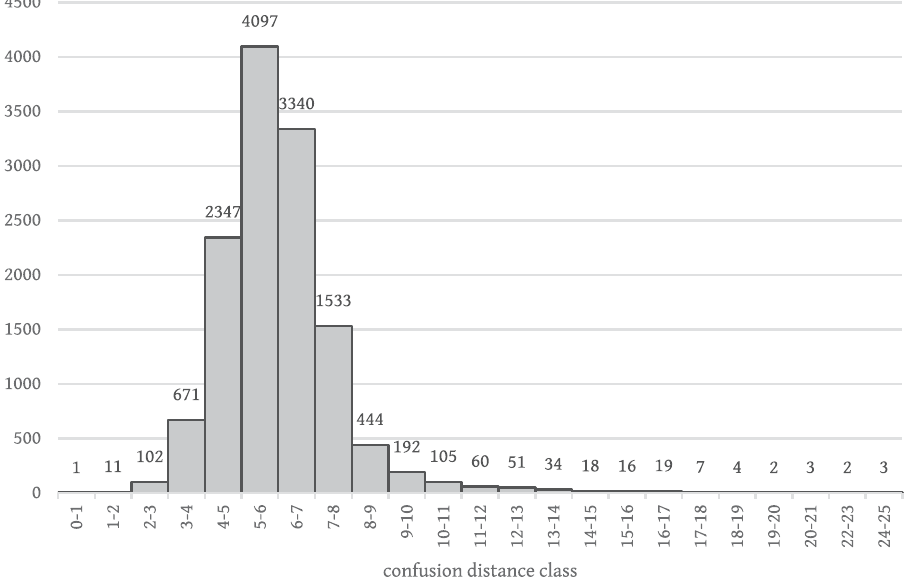
Figure 2: Frequency diagram of palaeographical confusion distances with IO ϒΔ AIAN . The horizontal axis shows the number of toponyms in a class.